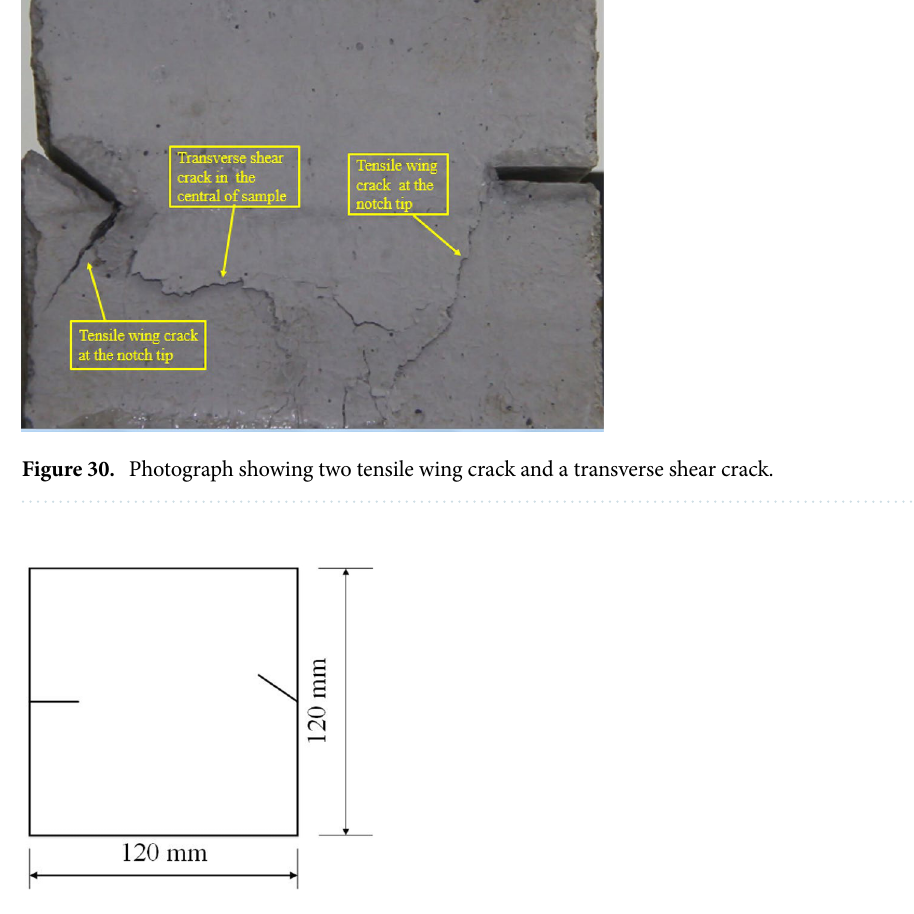
Figure 31. Specimen with two 20 mm long